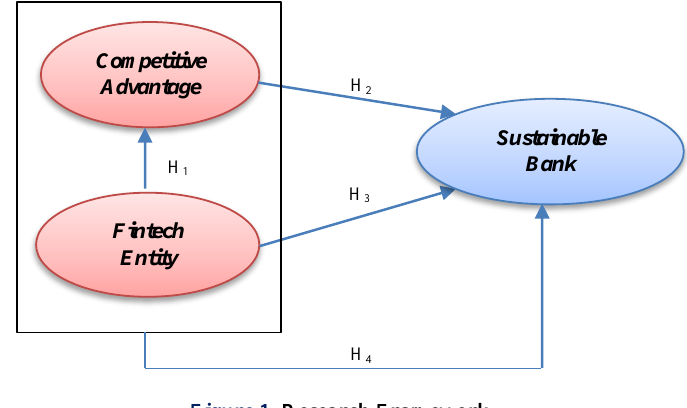
Figure 1. Research